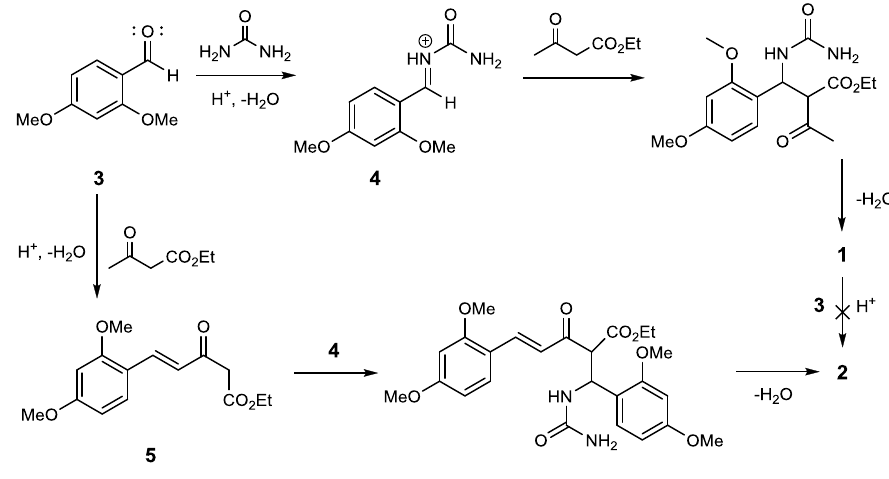
Figure 2. Proposed reaction pathway of compound 2 .